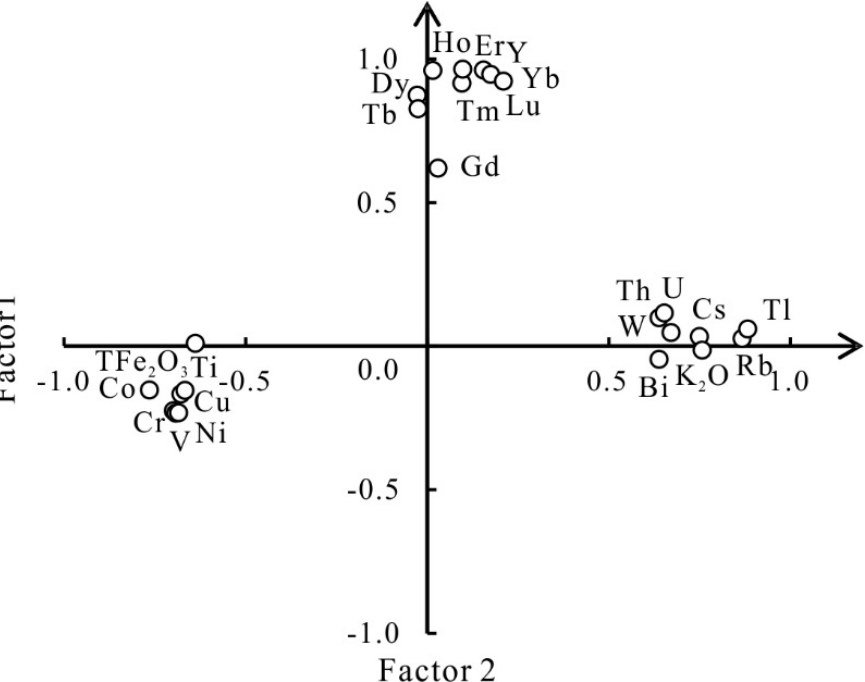
Figure 6. Biplot of Factor 1 (Bi − Th − U − W − Cs − K 2 O − Rb − Tl − (V − Cr − Cu − Ni − Co − Ti − TFe 2 O 3 )) vs. Factor 2 (Er − Tm − Ho − Yb − Lu − Y − Dy − Tb − Gd association). Circles indicate